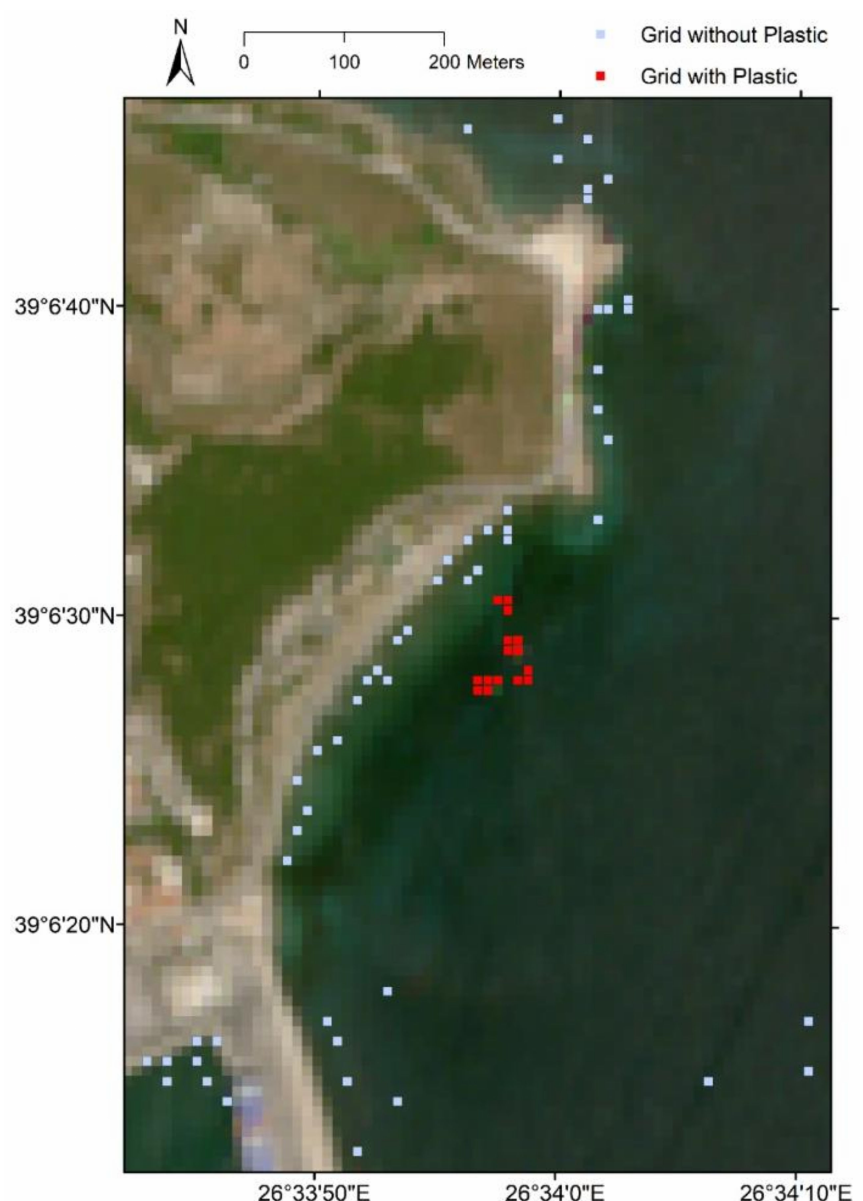
Figure 4. Grids with/without floating plastics belonging to the validation set at Mytilene, Greece based on in situ